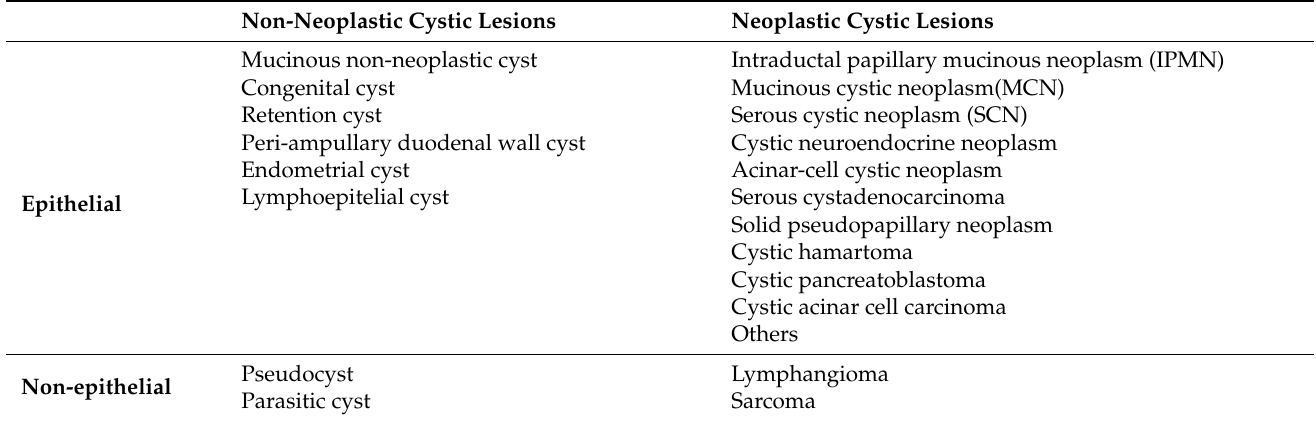
Table 1. Classification of pancreatic cystic lesions